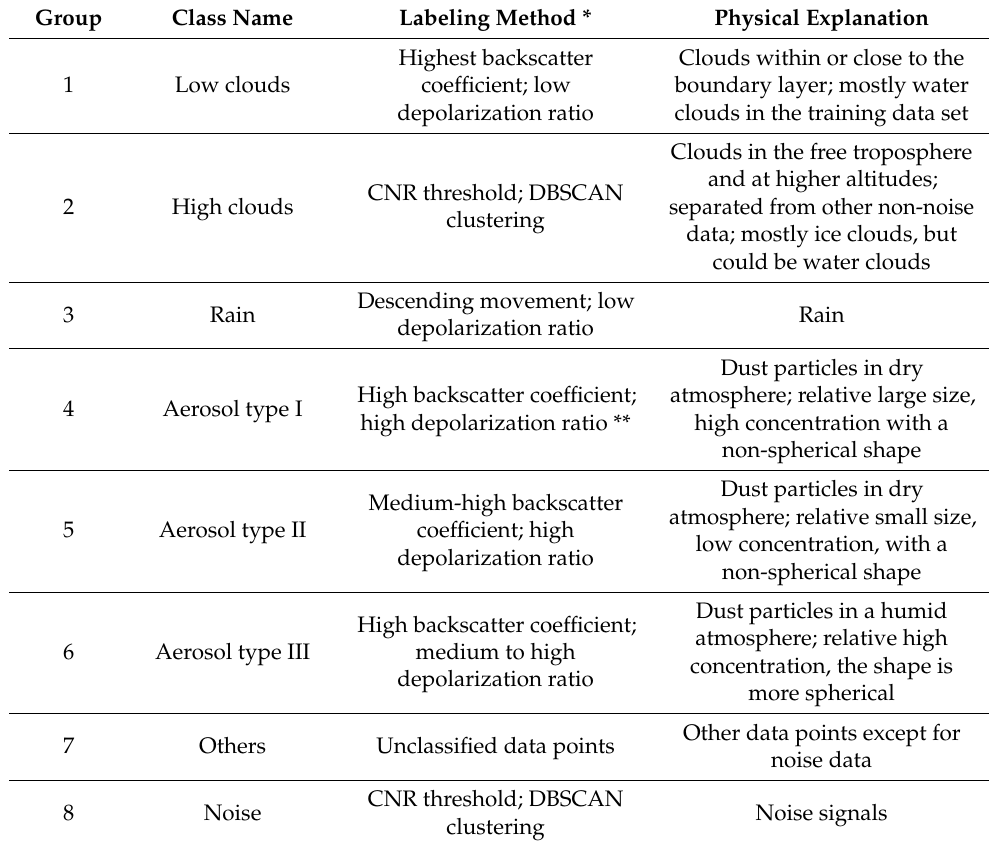
Table 2. The eight classes used in this study and their labeling methods and physical explanation.